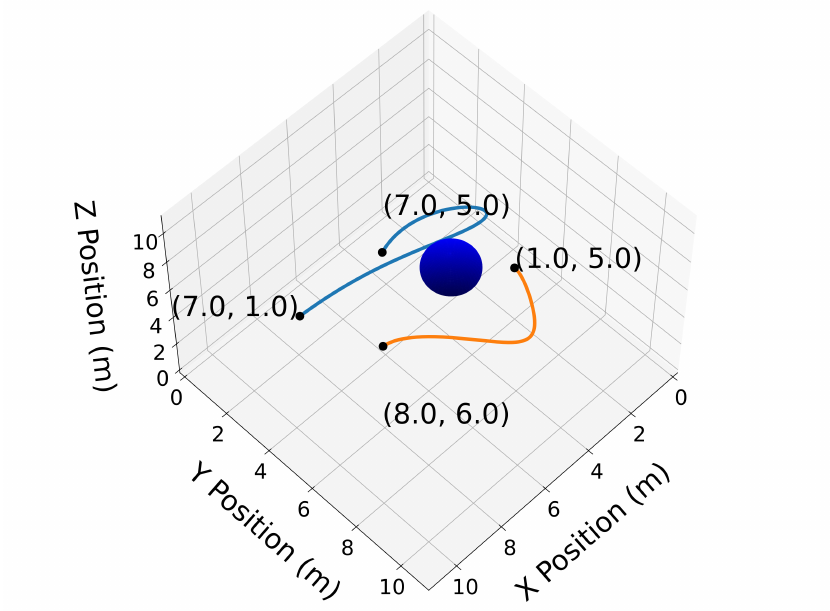
Figure 11. 3D trajectories C [ 3 ] ( t ) and C [ 4 ] ( t ) with their endpoints highlighted.